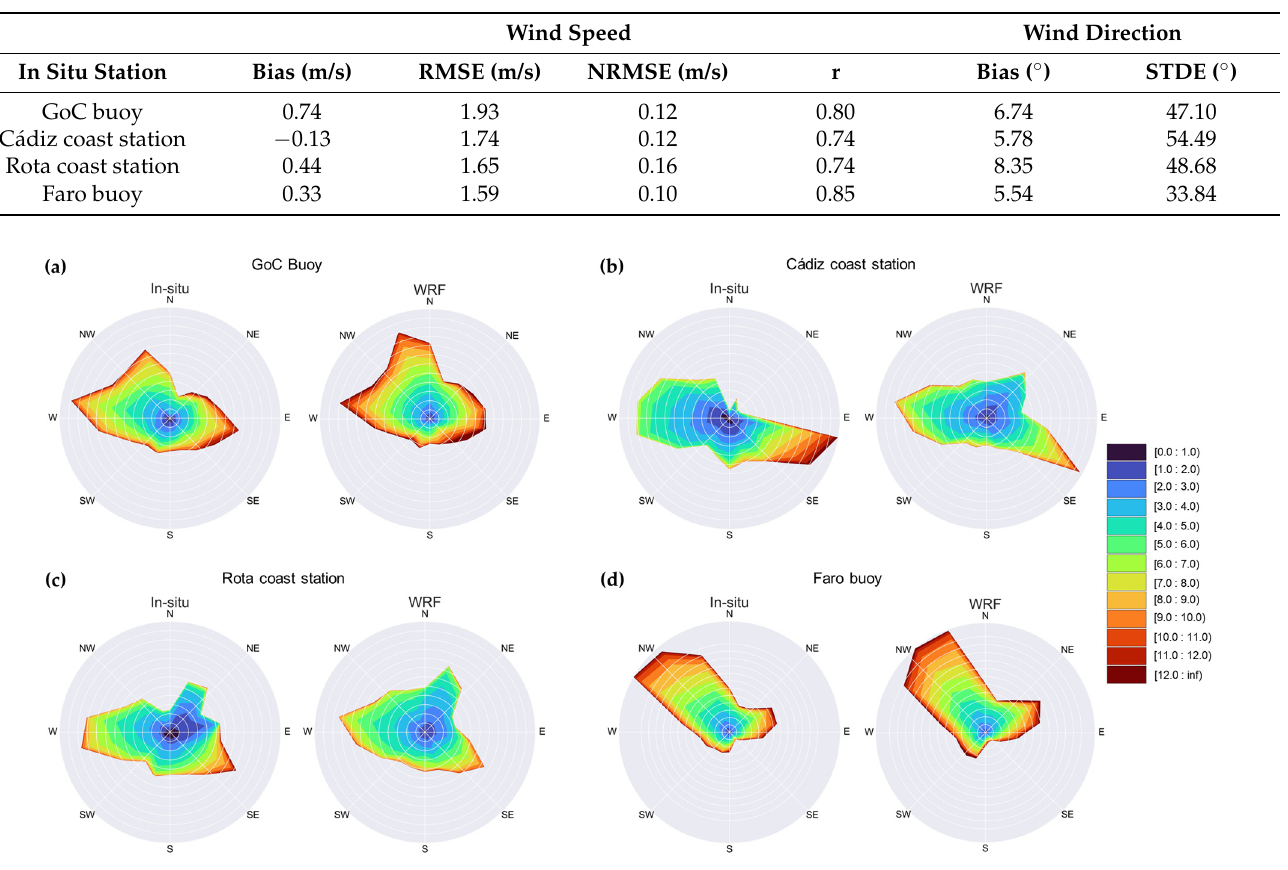
Figure 5. Wind rose diagrams (m/s) calculated at ( a ) GoC buoy, ( b ) Cádiz coast station, ( c ) Rota coast